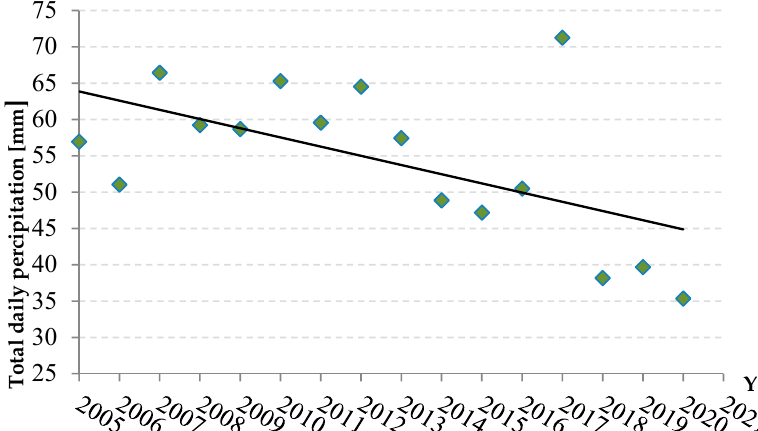
Figure 2. Average daily precipitations in the Gołdap region in 2005–2021 in Poland [27].